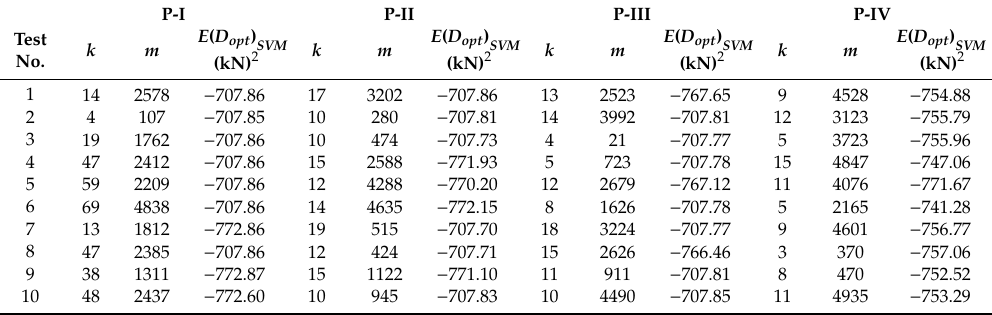
Table 5. Optimal objective function values with search algorithms run with di ff erent adjustments.